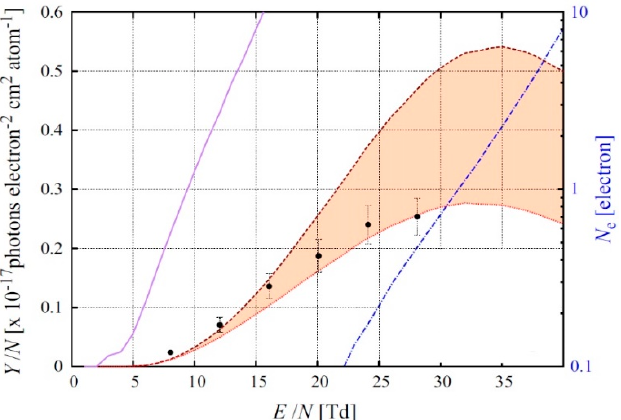
Figure 12. Reduced EL yield in gaseous Ar as a function of the reduced electric field, for atomic EL in the NIR due to atomic transitions going via Ar * (3p 5 4p 1 ) excited states, measured in [15] at 163 K (data points) and theoretically calculated in [23] (hatched area between two curves) (from [23], with permission from Elsevier). For comparison, that for ordinary EL in the VUV going via Ar * (3p 5 4s 1 ) (solid curve) and the number of secondary electrons due to electron avalanching in 2 mm gap (dashed-dot curve, right scale), theoretically calculated in [23], are shown.